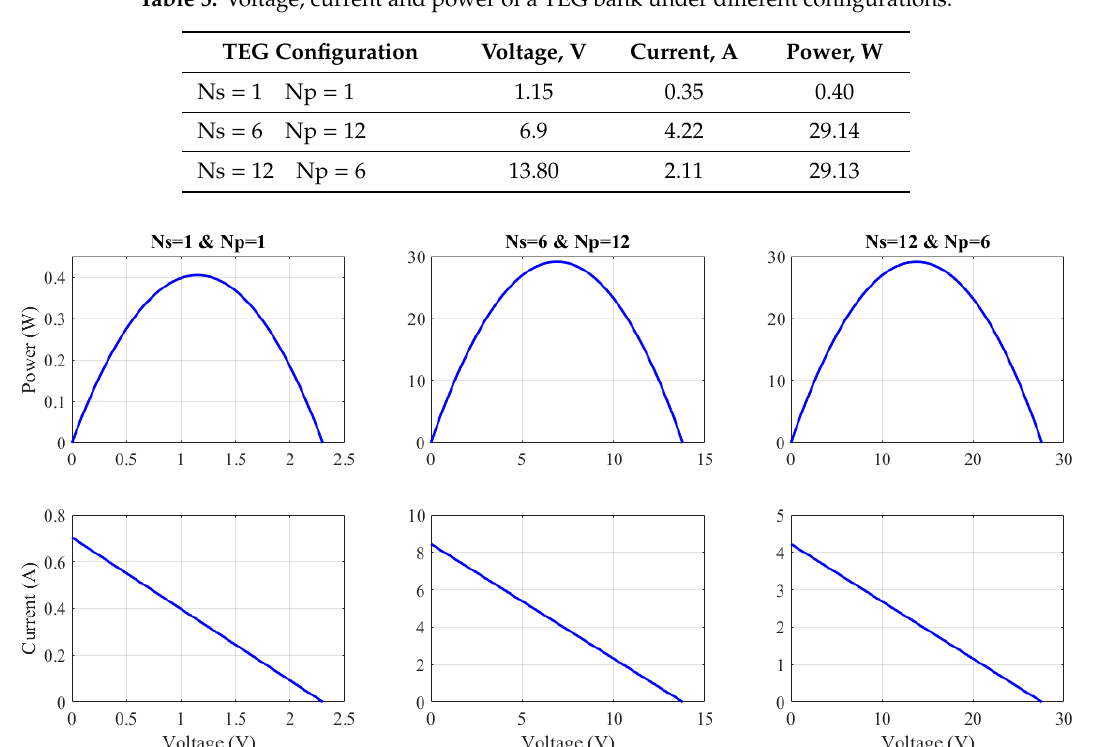
Figure 9. TEG voltage, current and power curves.